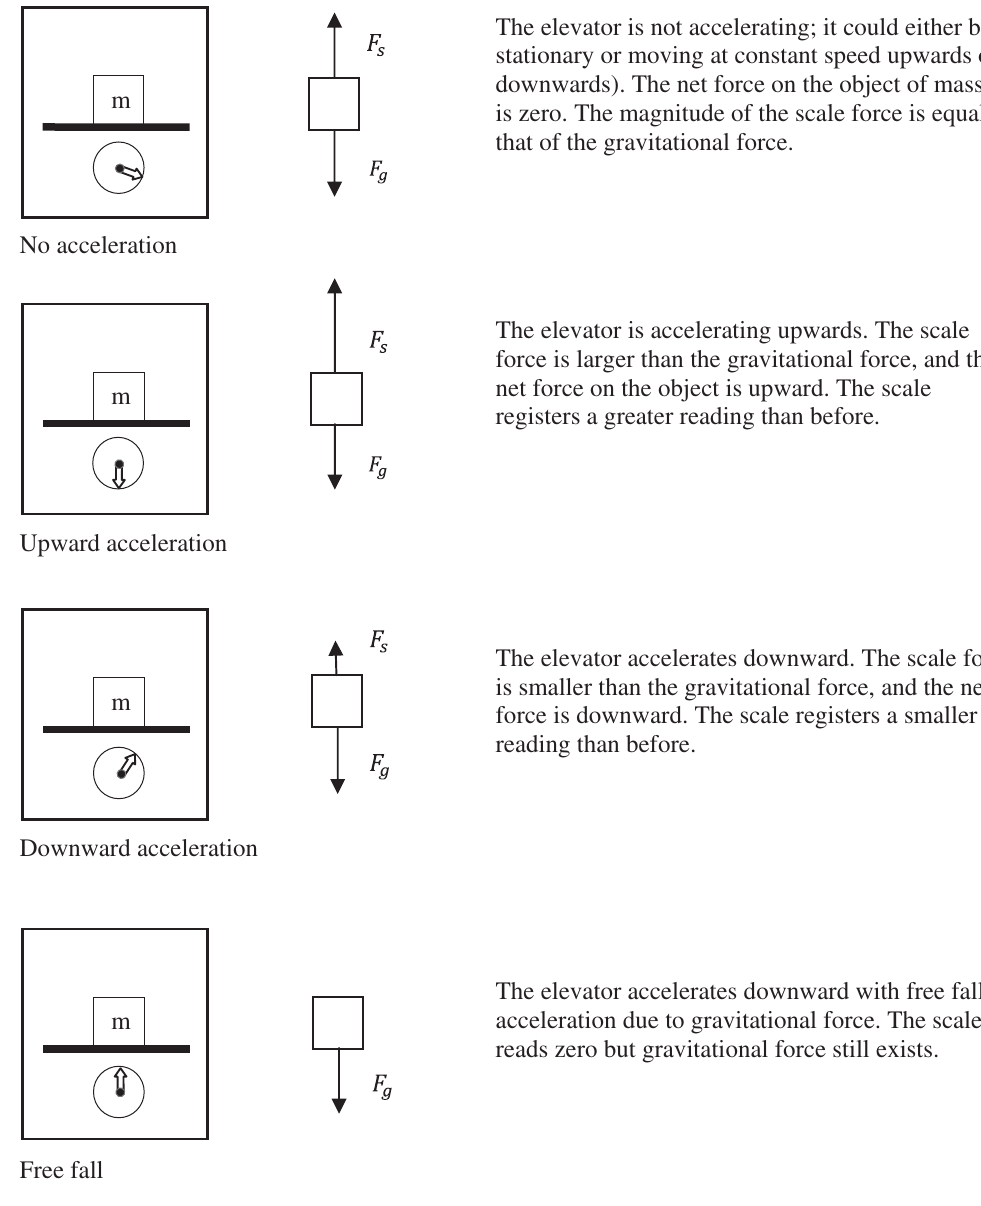
FIG. 2. Relationship between the gravitational and scale forces (the case of an